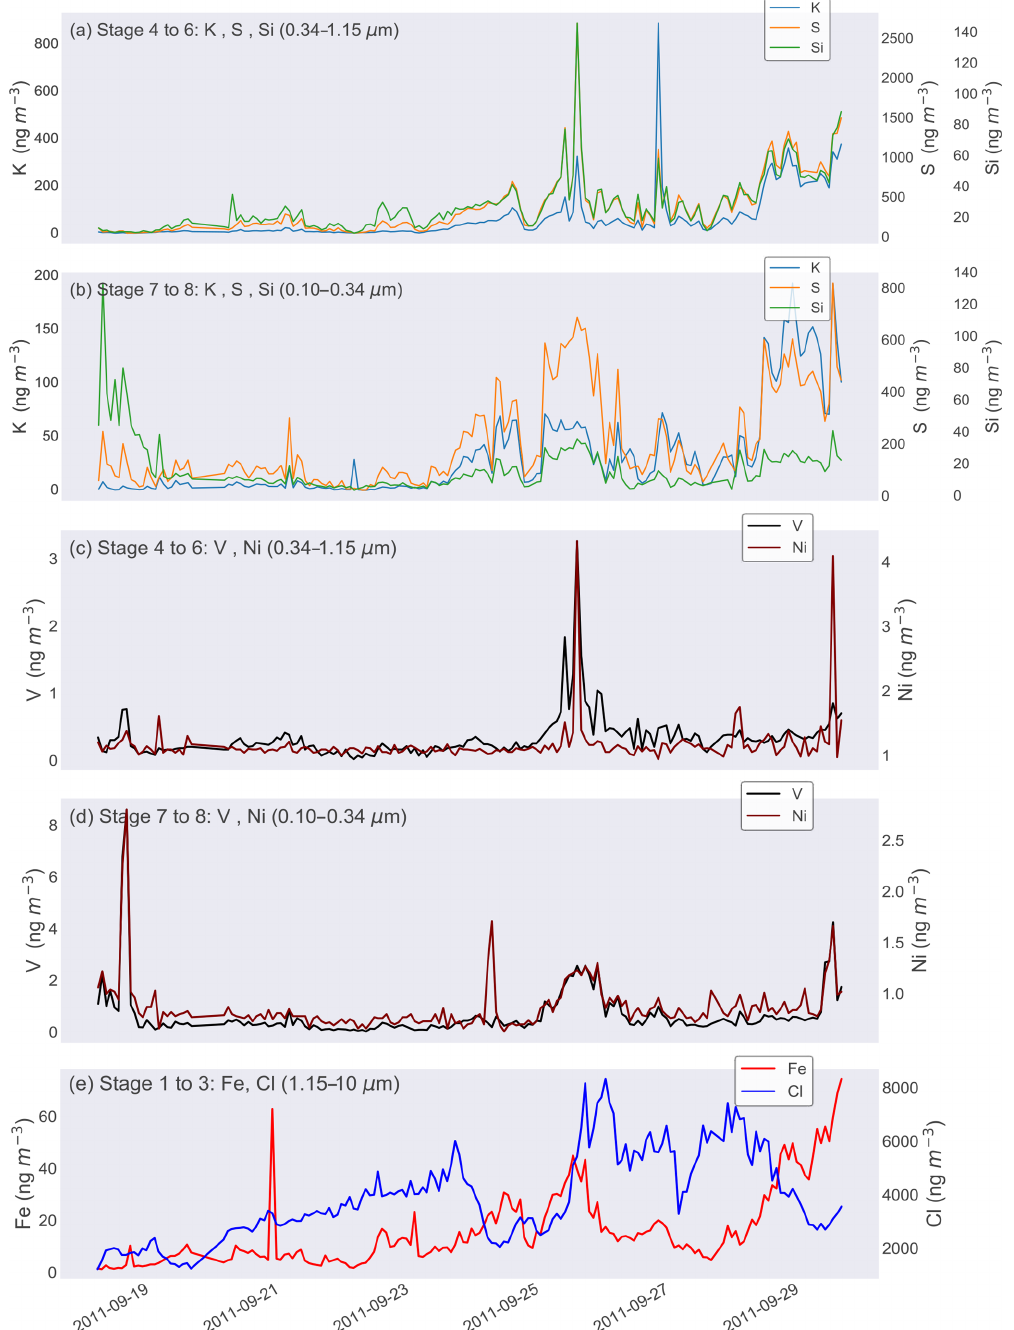
Figure 4. Time series of (a) stage 4–6 K, S, and Si; (b) stage 7–8 K, S, and Si; (c) stage 4–6 V and Ni; (d) stage 7–8 V and Ni; and (e) stage 1–3 Fe and